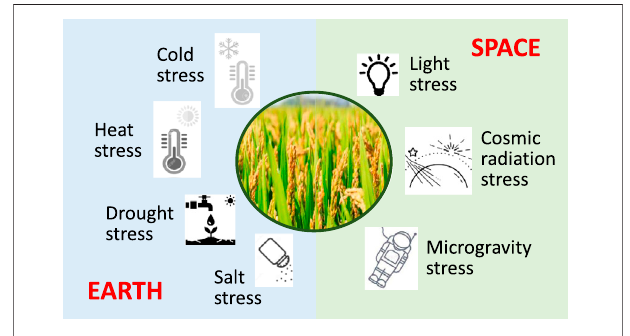
FIGURE 4 | Abiotic stresses on Earth and in space. Light stress is assigned to space, albeit known as well on Earth for reasons given in the respective text.